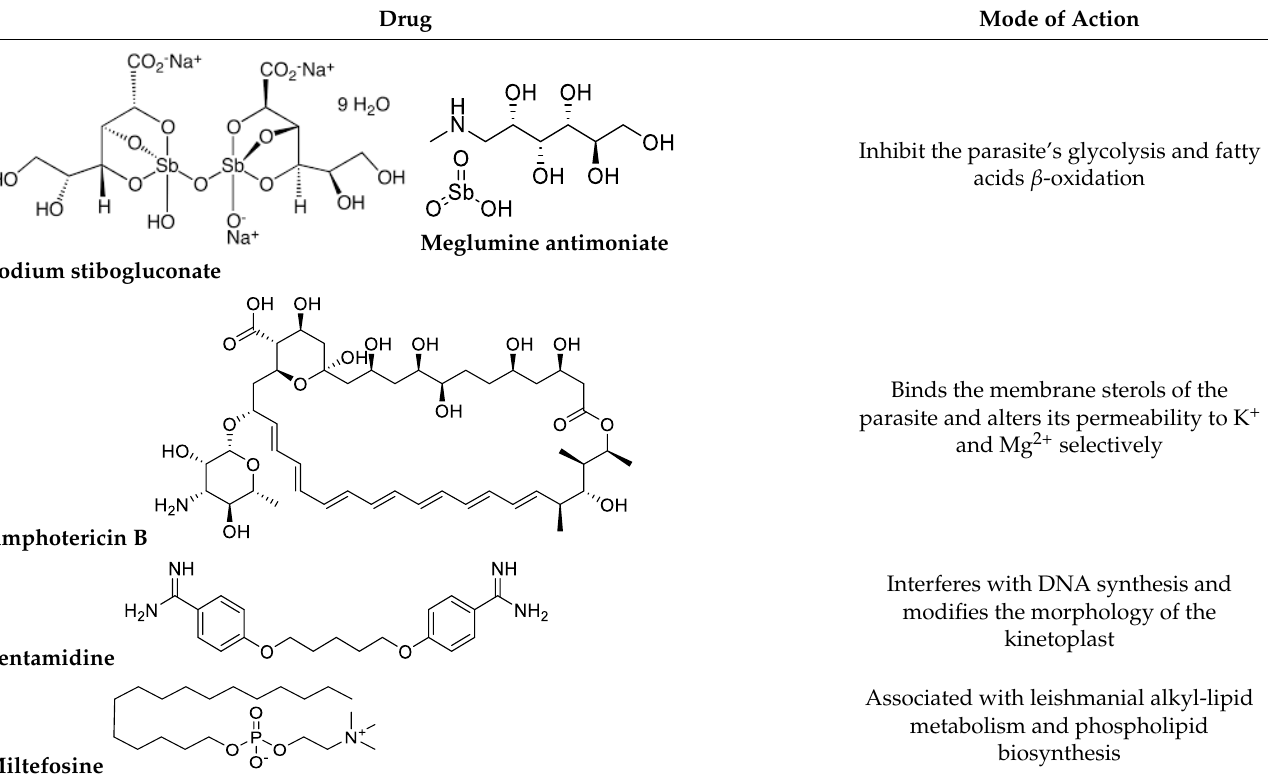
Inhibit the parasite’s glycolysis and fatty acids β -oxidation